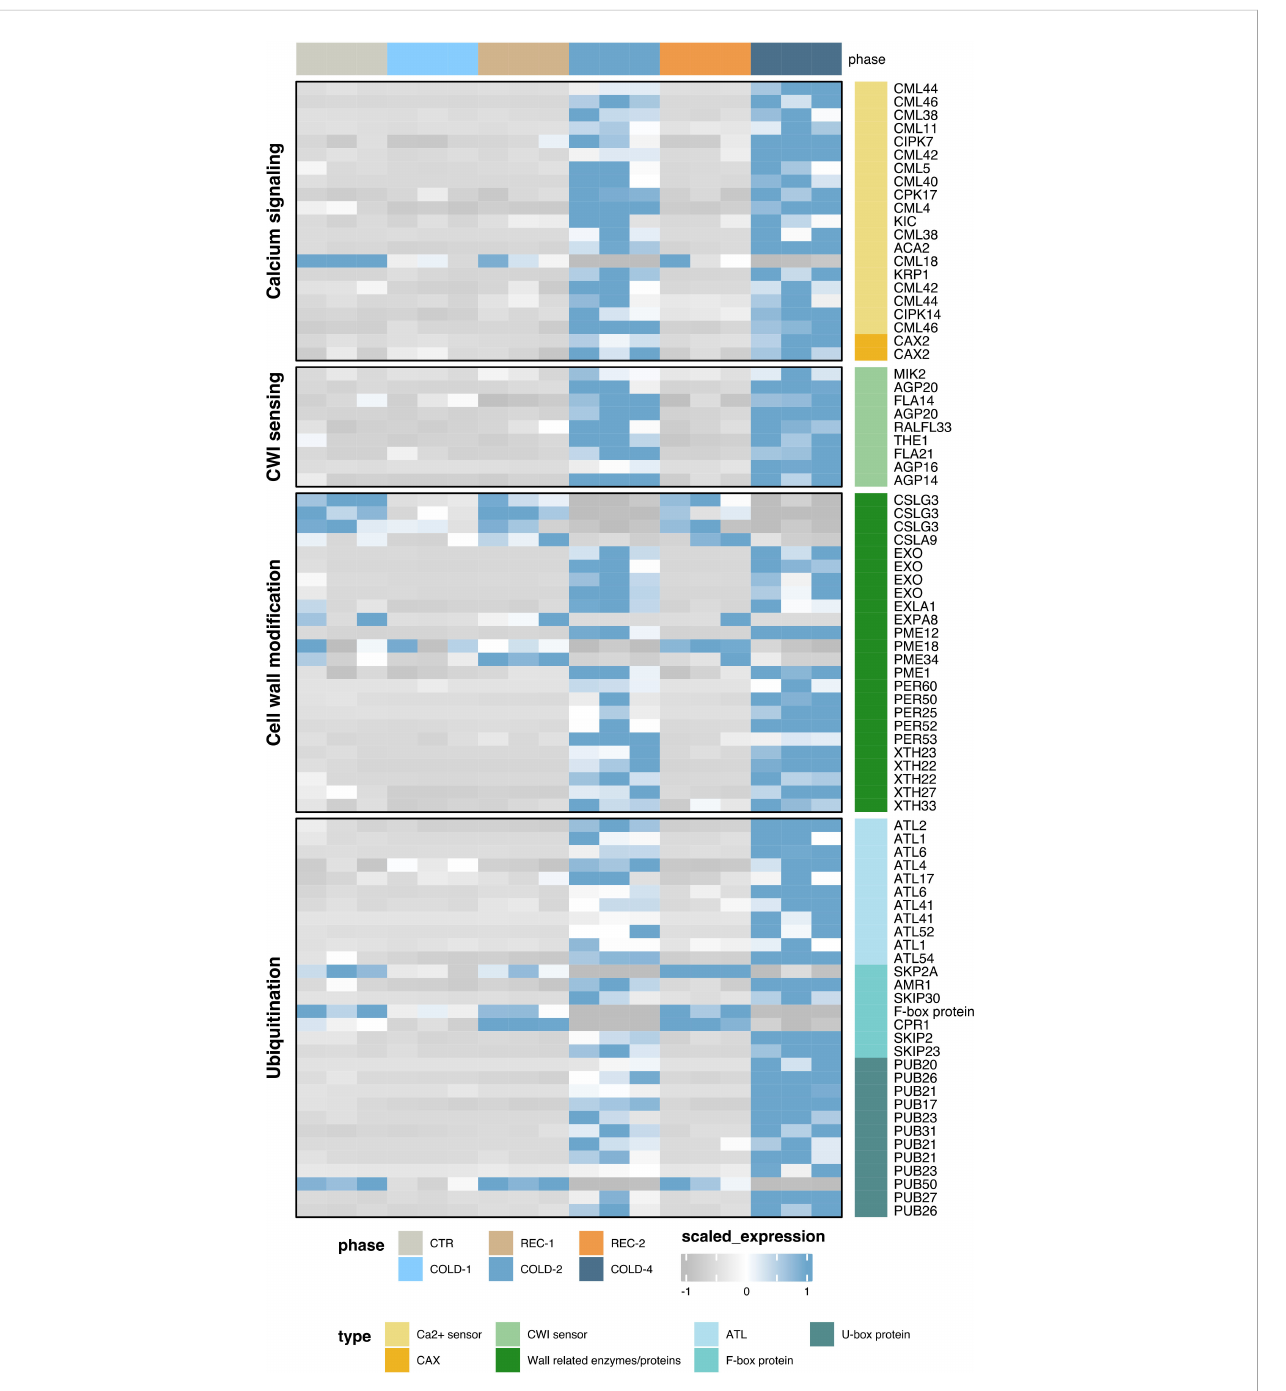
FIGURE 3 The expression heatmaps of CARGs involved in the calcium signaling, cell wall modi fi cation, and ubiquitination